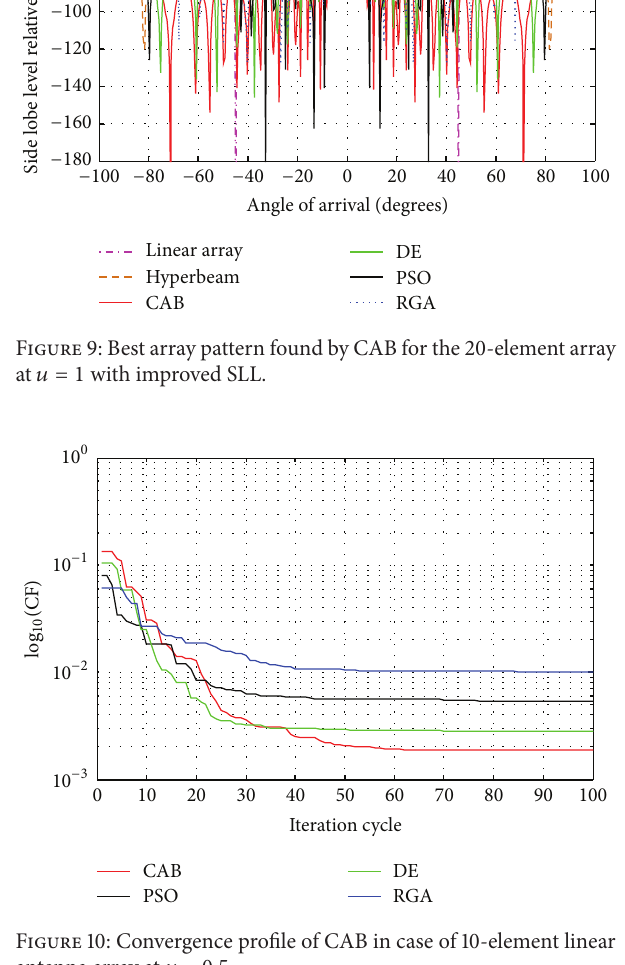
Figure 8: Best array pattern found by CAB for the 14 -element array at 𝑢 = 1 with improved SLL.